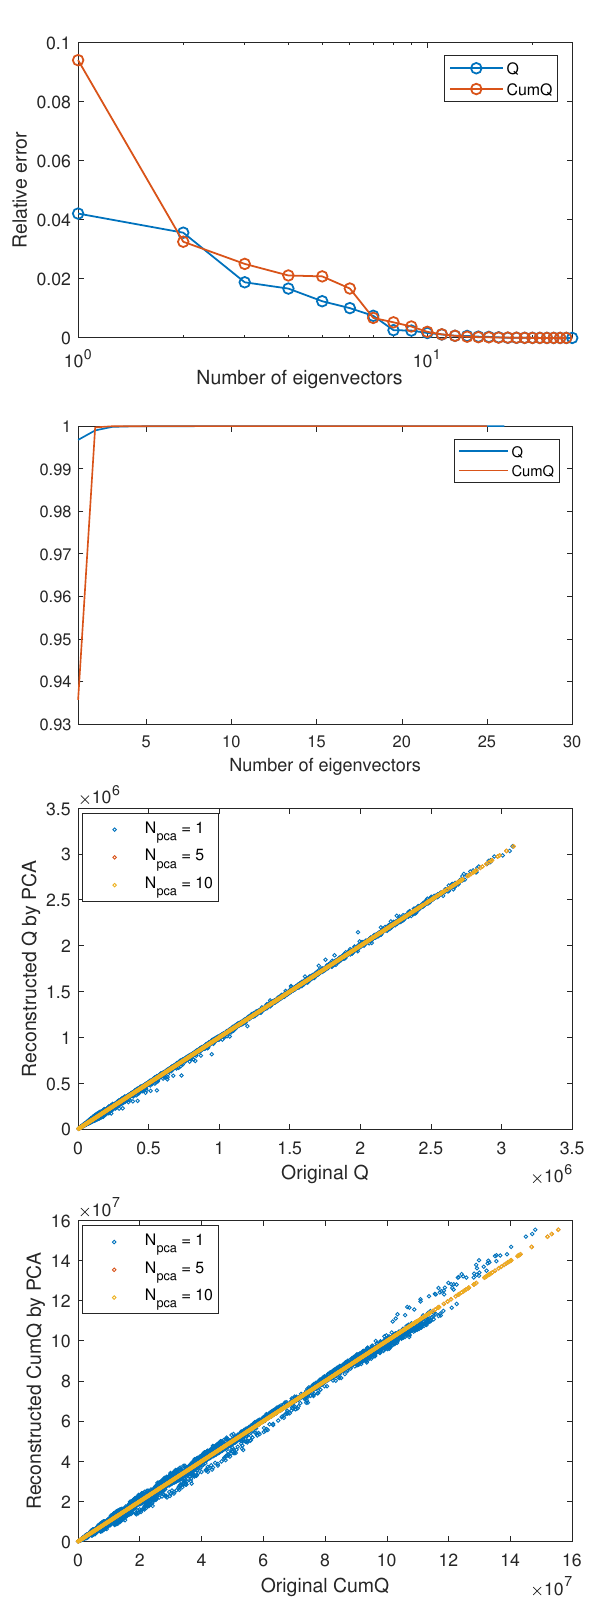
Figure 6. The dimensionality reduction using propel component analysis. The first two subfig- ures show the decay of Eigen-spectrum of PCA for the shale gas rate and cumulative gas produc- tion. The last two subfigures show the crossplots of the reconstructed shale gas rate and shale gas production,